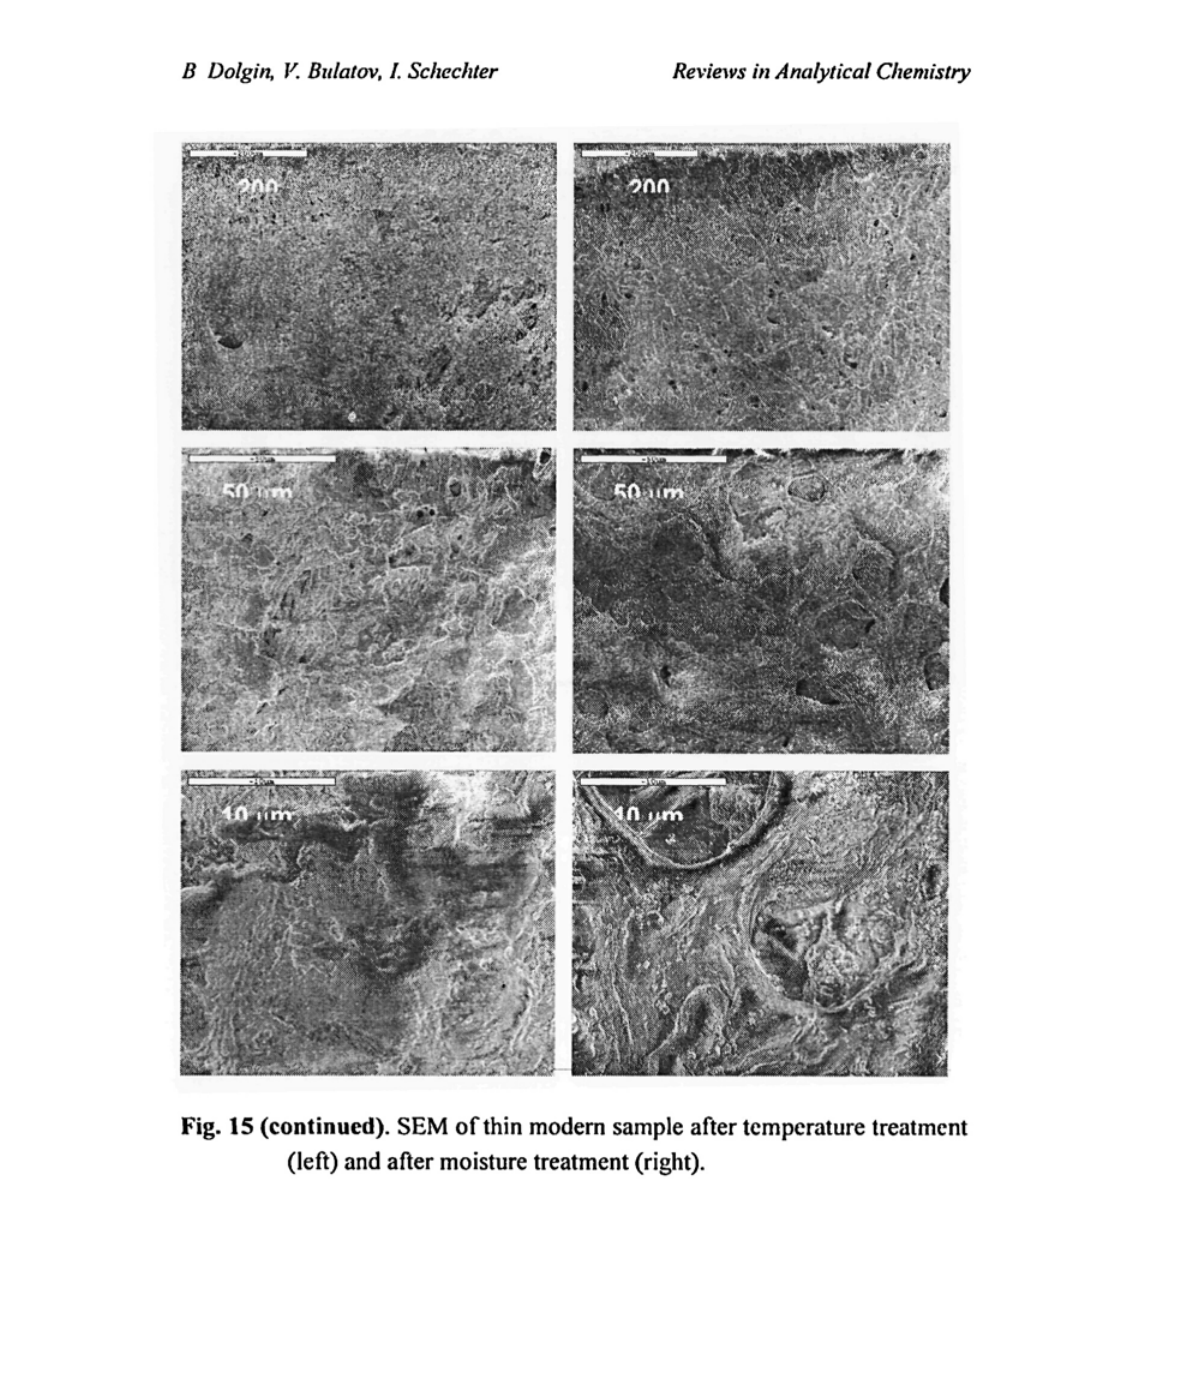
Fig. 15 (continued). SEM of thin modern sample after temperature treatment (left) and after moisture treatment